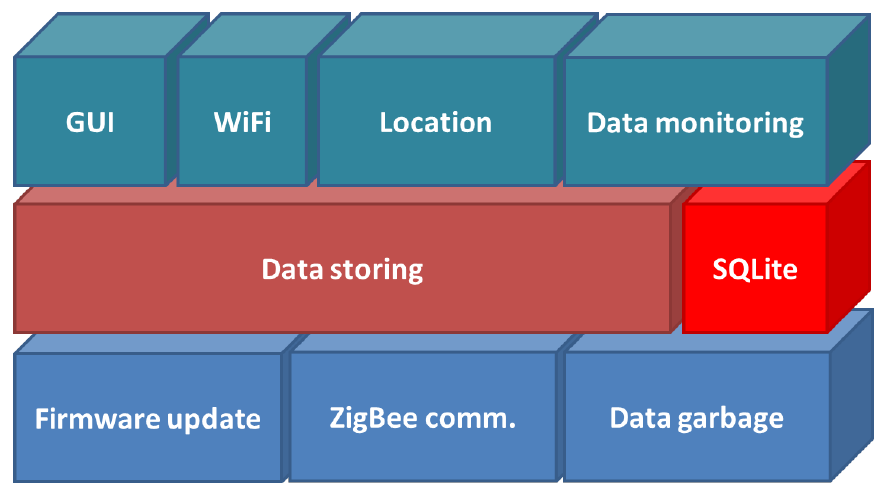
Figure 14. Middleware architecture.